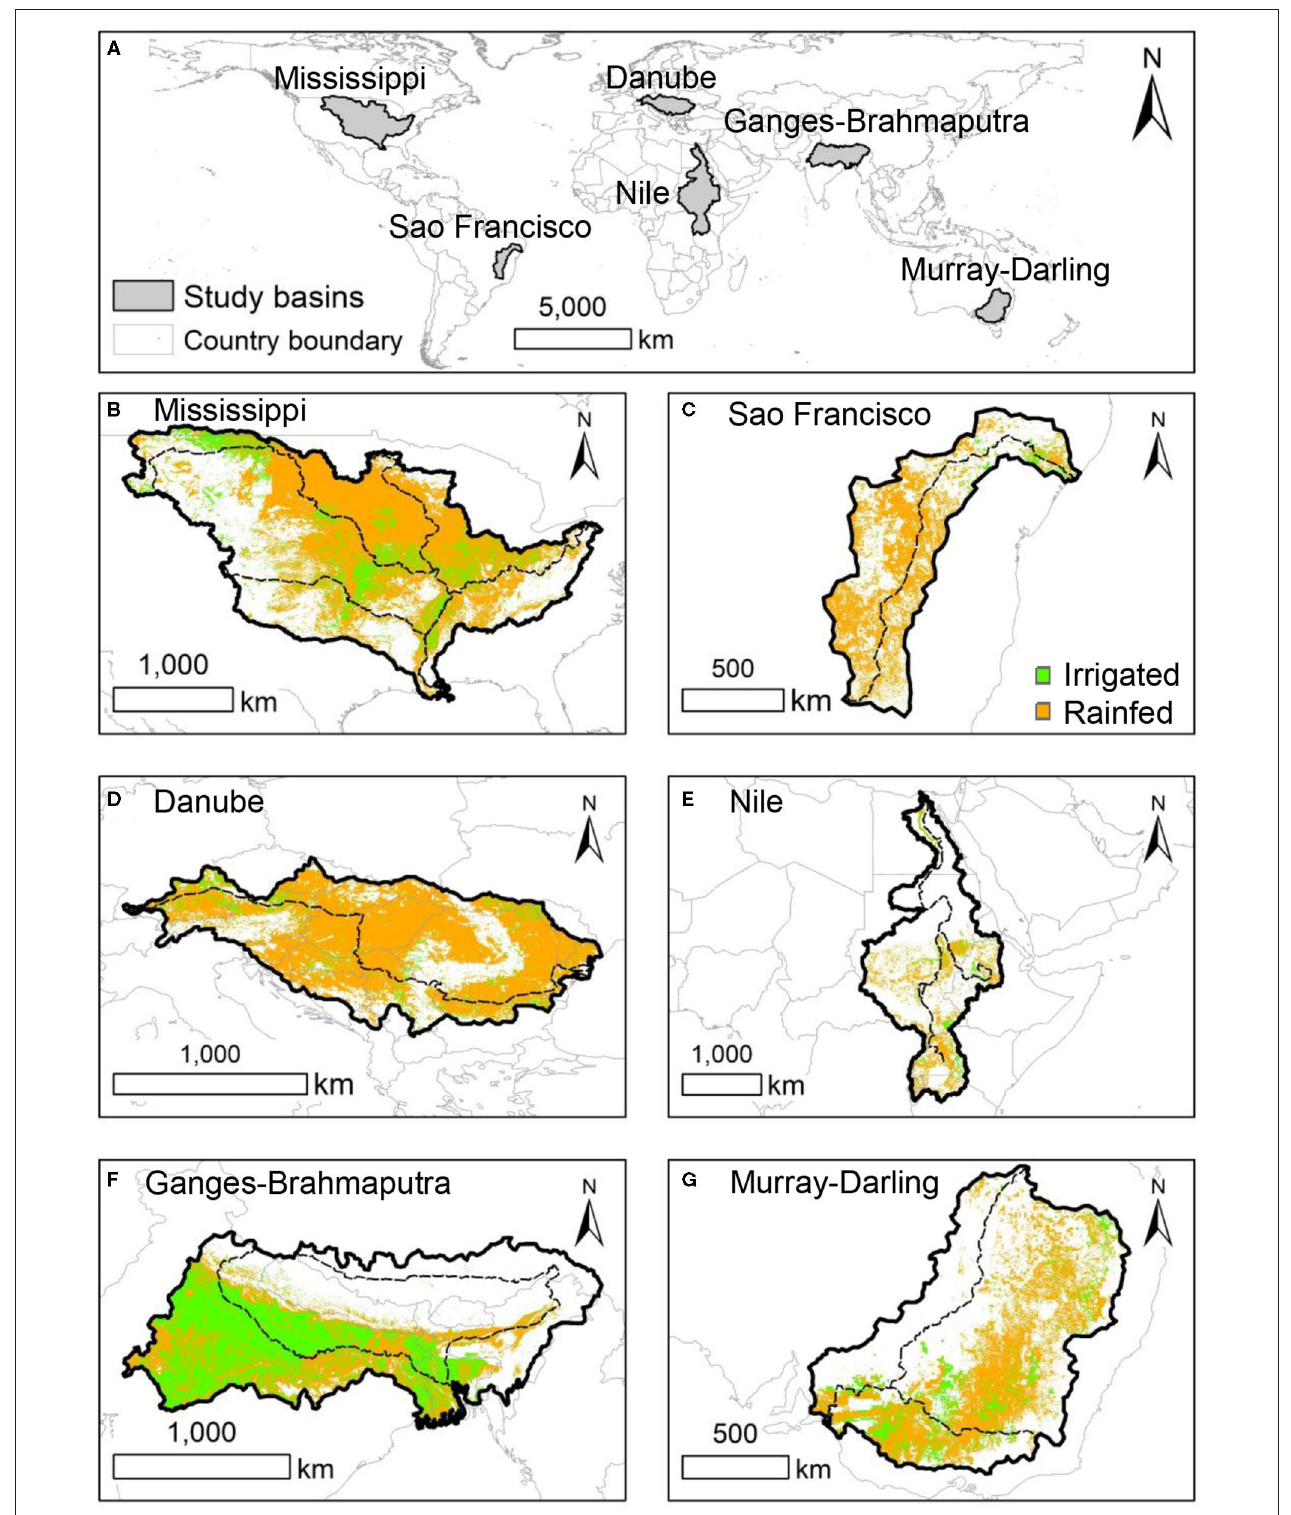
FIGURE 1 | The global map showing the location of six study basins (A) , including Mississippi (B) , Sao Francisco (C) , Danube (D) , Nile (E) , Ganges-Brahmaputra (F) , and Murray-Darling (G) . The dashed black color line inside the basins represents the major rivers. The croplands map is from the Global Food Security Support Analysis Data (https://lpdaac.usgs.gov/products/gfsad1kcmv001/) and basin boundaries are from World Resources Institute (https://www.wri.org/).